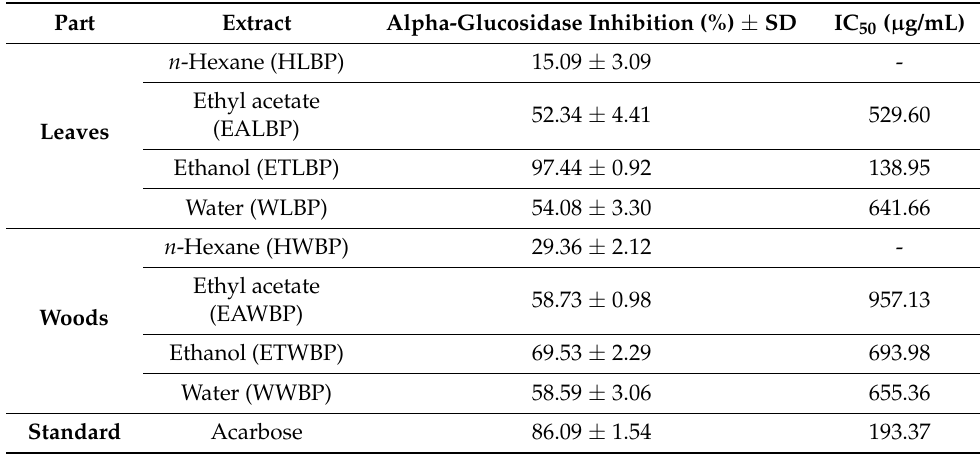
Table 1. Alpha-glucosidase inhibition test for Bauhinia pulla extract